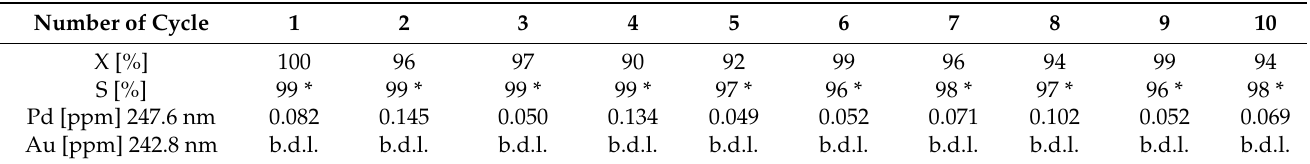
Table 4. ICP-AES analysis of reaction mixture after stability tests of the 5% Pd-1% Au/SiO 2 catalyst. Reaction conditions: